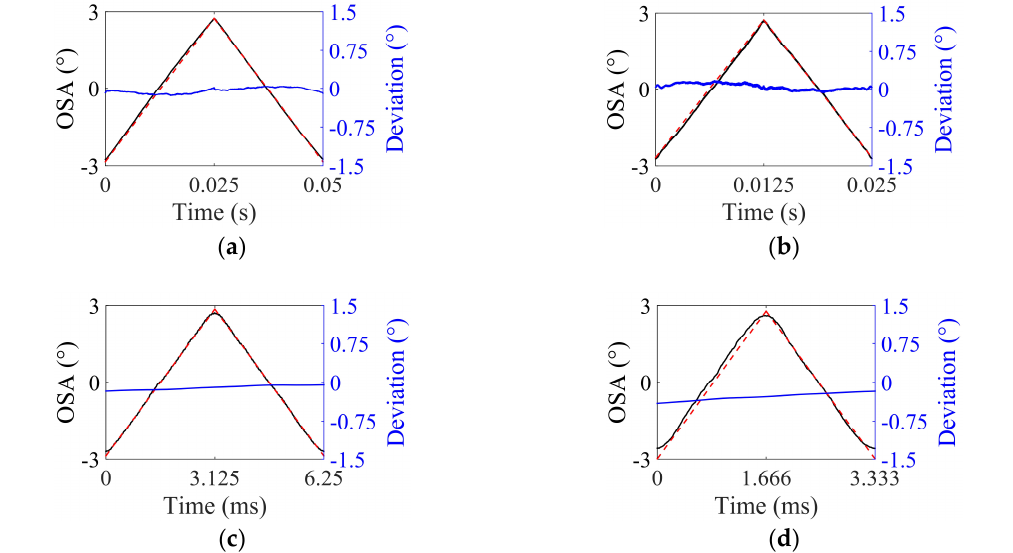
Figure 10. Performance of the ISETF with respect to the driving frequency (driving voltage: 25 V, sampling rate: 50 kHz): ( a ) 20 Hz, ( b ) 40 Hz, ( c ) 160 Hz, and ( d ) 300 Hz (scan output using the ISETF: solid line in black; ideal triangular output: dashed lines in red).